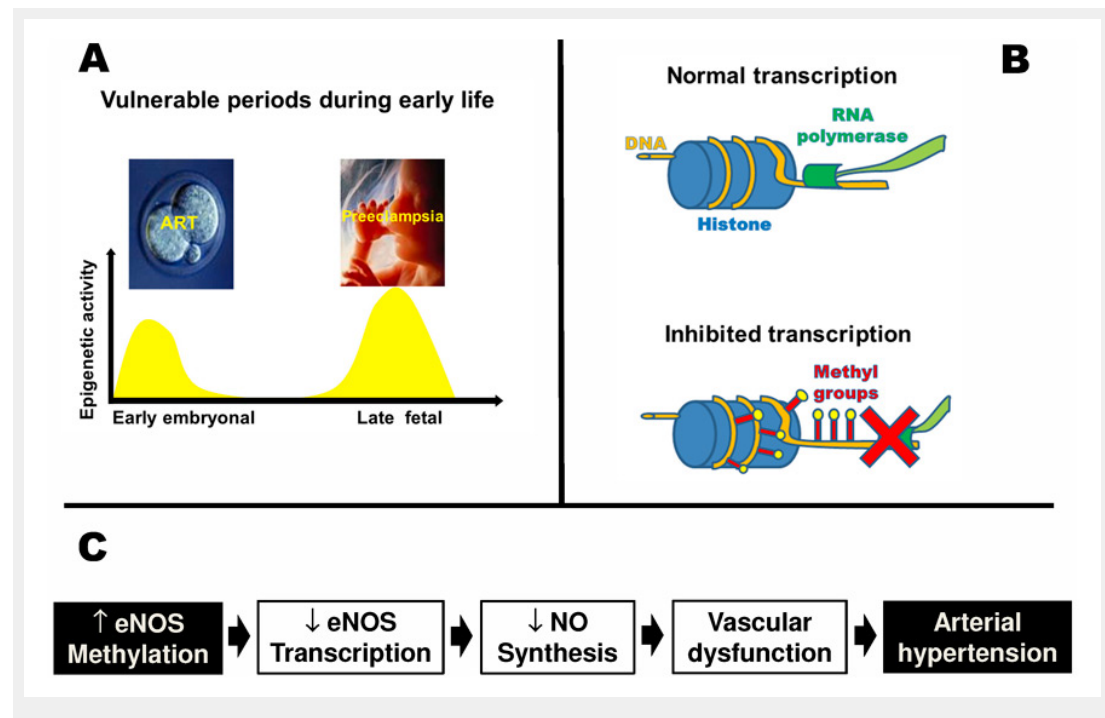
Figure 2 Role of epigenetic alterations in the fetal programming of vascular dysfunction. Vulnerable periods during early life known to be associated with fetal programming of cardiovascular disease coincide with increased epigenetic activity (Panel A). Increased DNA methylation inhibits of transcription (Panel B). In mice conceived by assisted reproductive technologies, DNA-methylation of the eNOS gene was altered resulting in decreased eNOS transcription in the vasculature and impaired vascular nitric oxide synthesis. These problems translated into vascular dysfunction and arterial hypertension (Panel